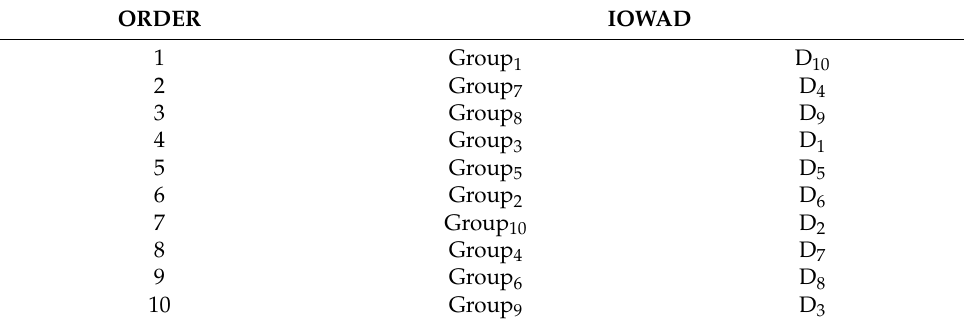
Table 15. Assignation process with IOWAD operator. ORDER